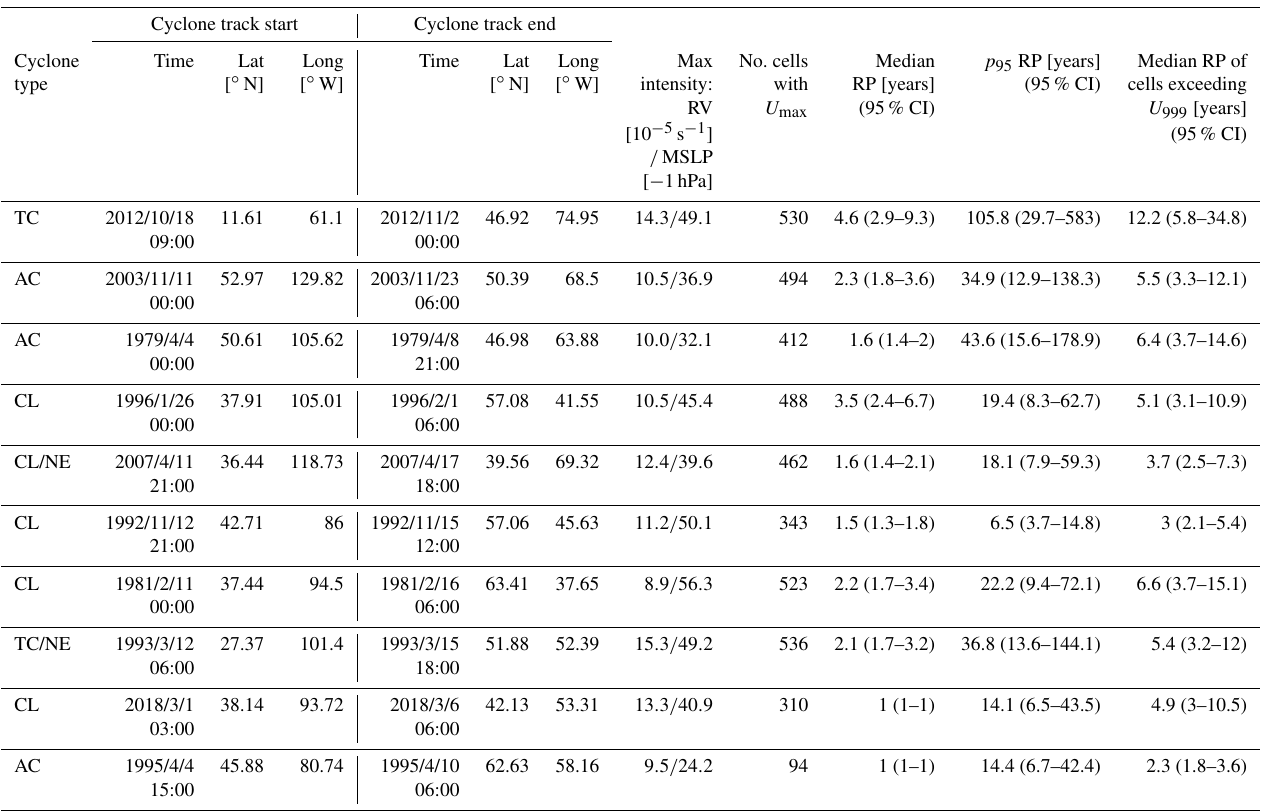
Table 3. Windstorm details (windstorms are ordered as in Table 2). Cyclone type is based on subjective evaluation of results from the cyclone detection and tracking algorithm. AC – Alberta clipper. TC – tropical cyclone. CL – Colorado low. NE – nor’easter. Max intensity is the maximum cyclone intensity along the storm-associated cyclone tracks for RV ( × 10 − 5 s − 1 ) and MSLP (scaled by − 1, hPa). No. cells with U max indicates the number of grid cells for which the maximum wind speed for the storm year occurred within the storm period. Median RP is the 50th-percentile return period for maximum wind speed in each northeastern grid cell during each storm period, while p95 is the 95th-percentile RP. Also shown is the median RP for grid cells that exhibited U>U 999 at the storm peak. All RP values include a 95% confidence interval in